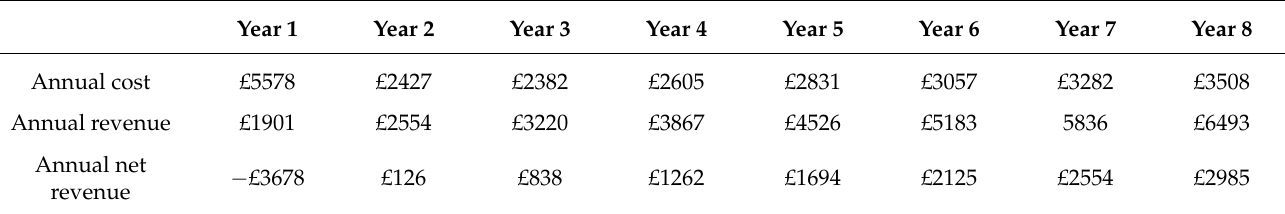
Table 21. Annual net revenue of County Durham (one charger and 0.005 GBP/kWh) in GBP.